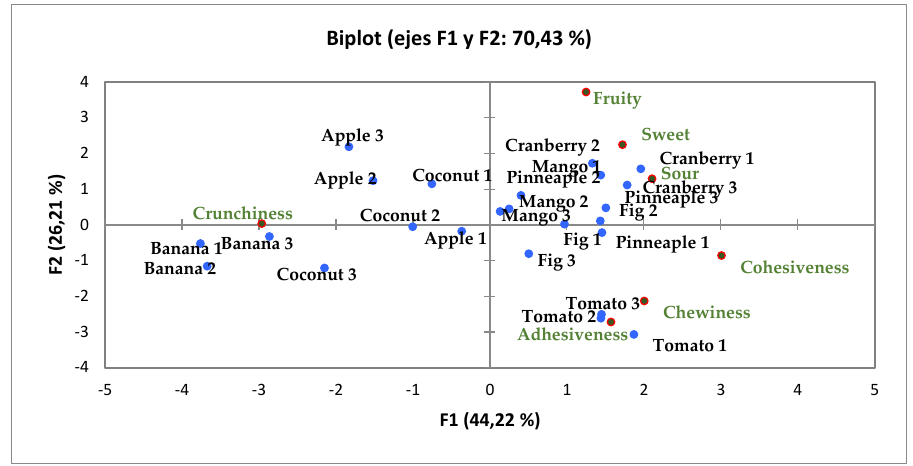
Figure 1. Principal component analysis of commercial dried fruit samples (PCA).